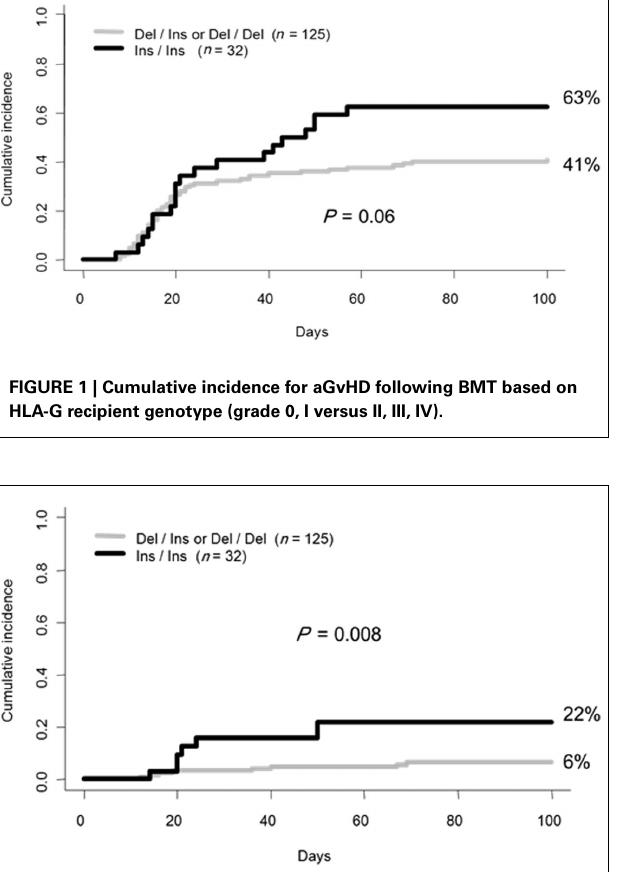
of such process is represented by the post-HSCT aGvHD.